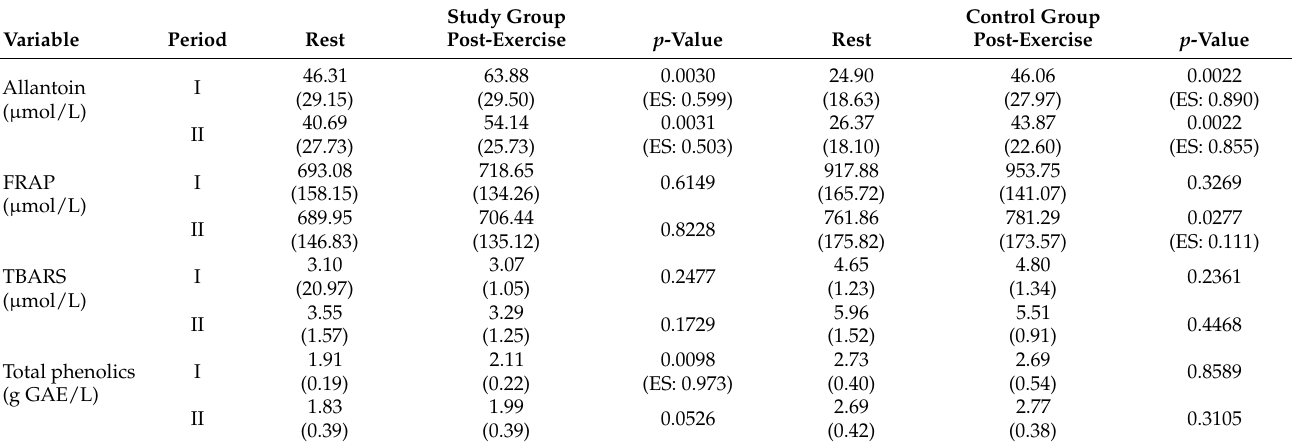
Table 3. The effect of exercise tests and 30 min daily endurance training on plasma allantoin, FRAP, TBARS, and total phenolics concentration (mean (SD)) in patients with COPD. Study Group Control Group